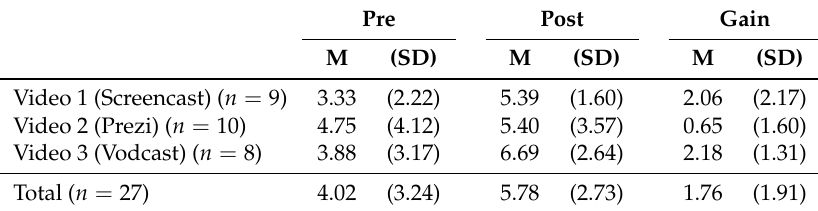
Table 2. Means and standard deviations of knowledge measures: before (pre) and after (post) watching the video, as well as the pre–post difference